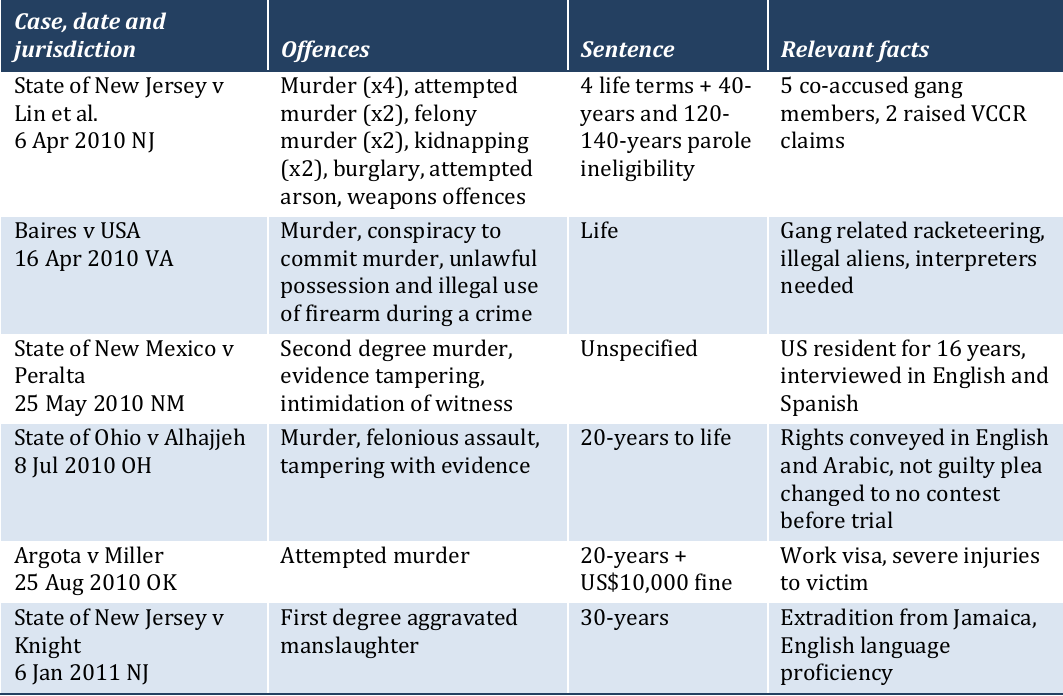
Table 1: US homicide cases raising Article 36, January 2010 ‐ July